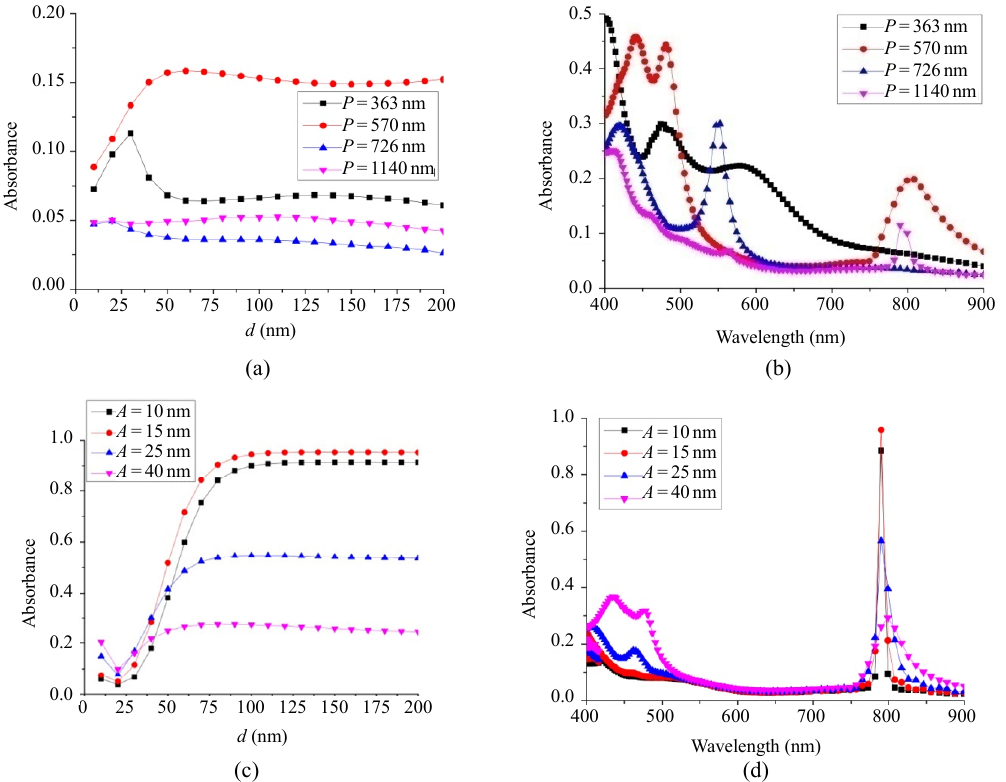
Fig. 6 Analysis of the period and amplitude of the 1D sinusoidal Ag nanograting: (a) calculated absorbance as the function of the Ag layer thickness for different periods at λ = 785 nm, (b) calculated absorbance as the function of the excitation light wavelength for different periods at d = 100 nm, (c) calculated absorbance as the function of the Ag layer thickness for different amplitudes at λ = 785 nm, and (d) calculated absorbance as the function of the excitation light wavelength for different amplitudes at d = 100 nm. Table 2 EF as a function of the grating amplitude at d = 100